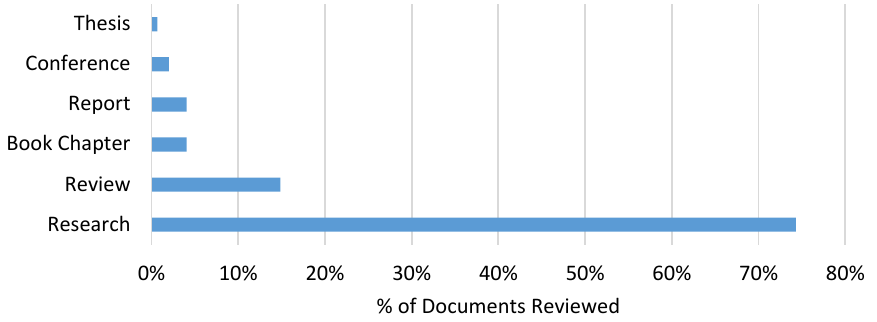
Figure 4. Research papers (74.3%), reviews (14.9%), book chapters (4.1%), conferences and reports (4.1%), and theses (0.7%) are the types of manuscripts included in the review.